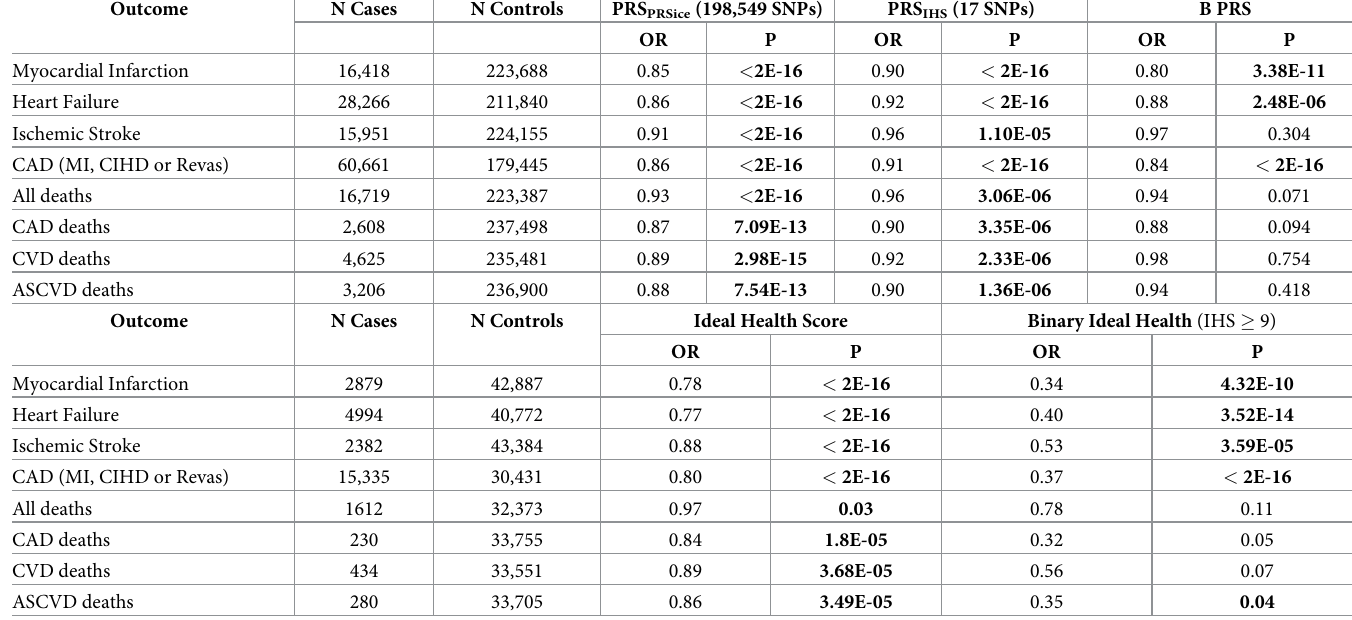
Table 4. Logistic regression analysis of cardiovascular disease outcomes and mortality outcomes using ideal cardiovascular health or genetically-defined ideal car- diovascular health.